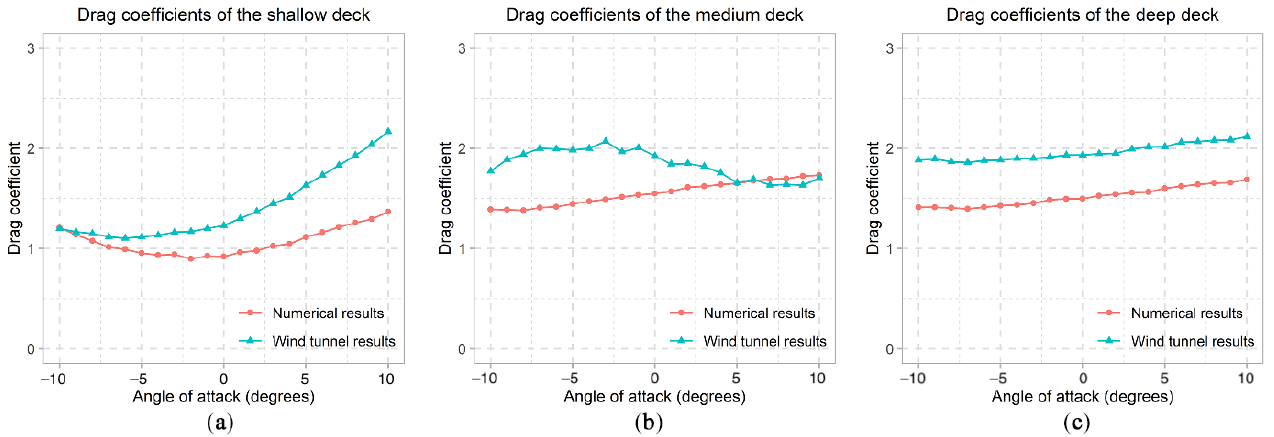
Figure 20. Drag coefficients of different bridge decks: ( a ) the shallow deck; ( b ) the medium deck; ( c ) the deep deck.